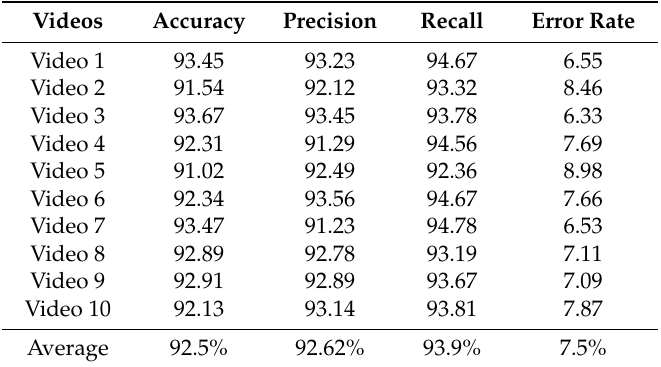
Table 10. Performance evaluation using